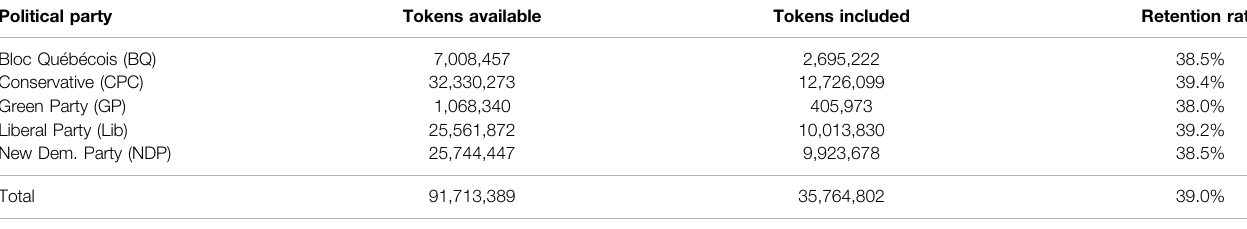
TABLE 3 | Rate of retention after lemmatized tokens without a rating in the Warriner et al. database were removed from the corpus. Political party